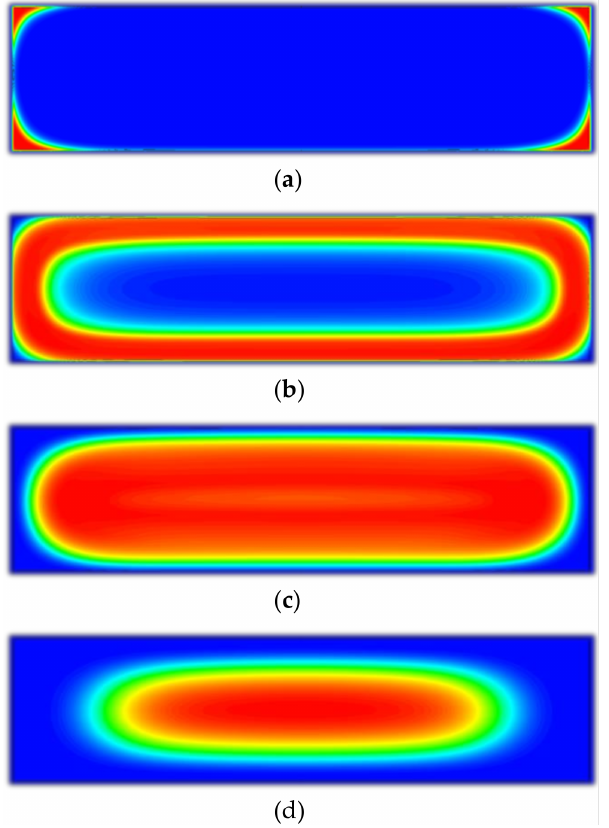
Figure 17. Char residue concentration at ( a ) t = 20 s, ( b ) 40 s, ( c ) 60 s and ( d ) 75